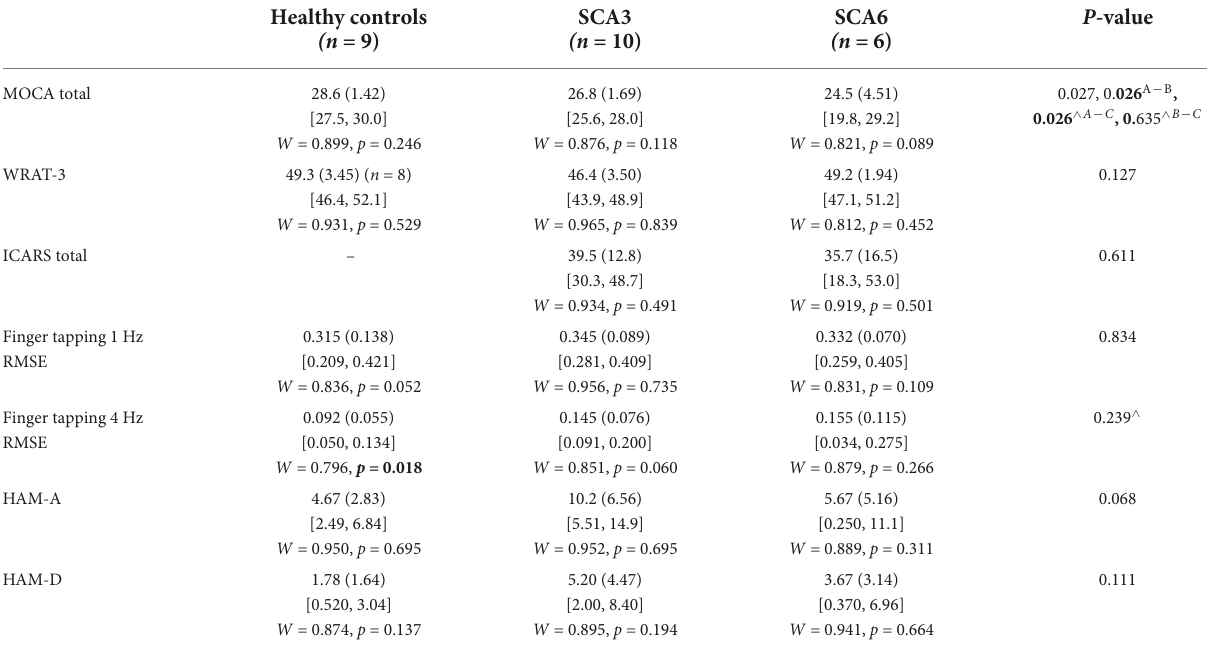
TABLE 2 Cognitive, neurological, and mood assessment